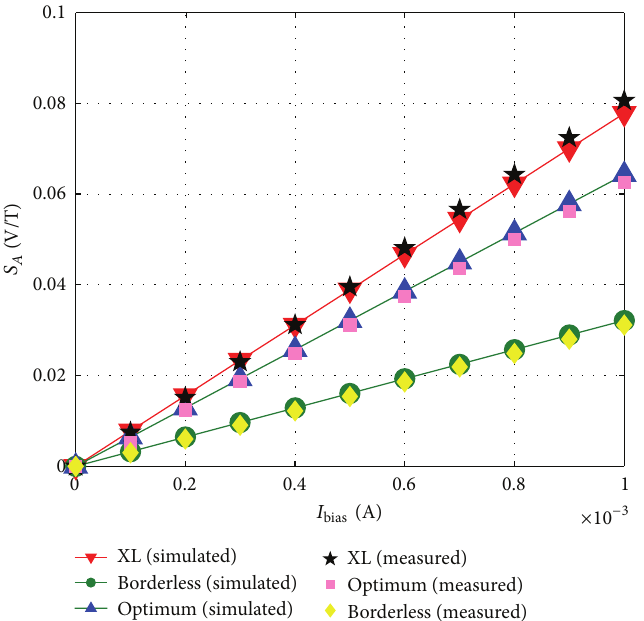
Figure 10: The simulated absolute sensitivity 𝑆 𝐴 versus the biasing current for three integrated Hall cells.